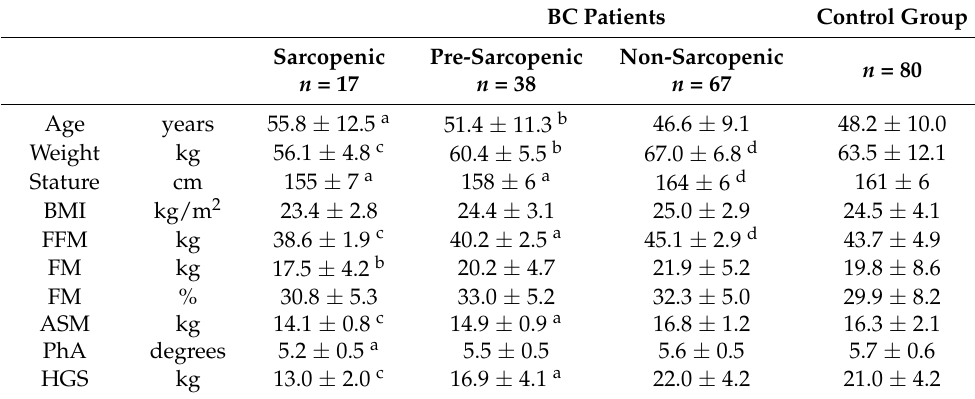
Table 4. Individual characteristics and body composition of sarcopenic, pre-sarcopenic and non- sarcopenic patients and the control